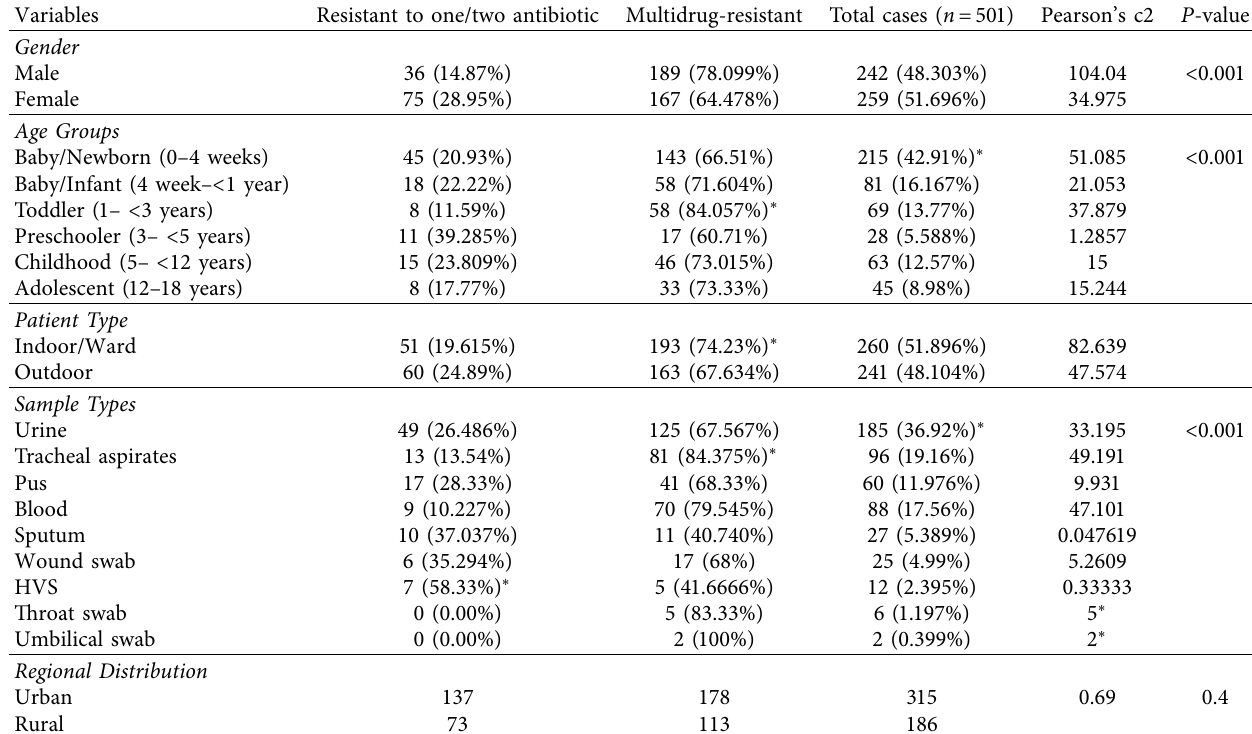
Table 1: Clinical characteristics of Kpn infected patients ( n �